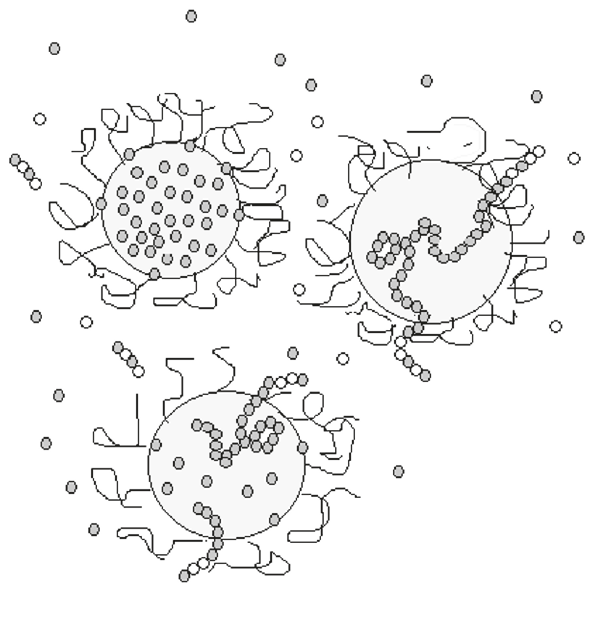
Figure 6: Schematic representation of the inverse emulsion poly- merization.